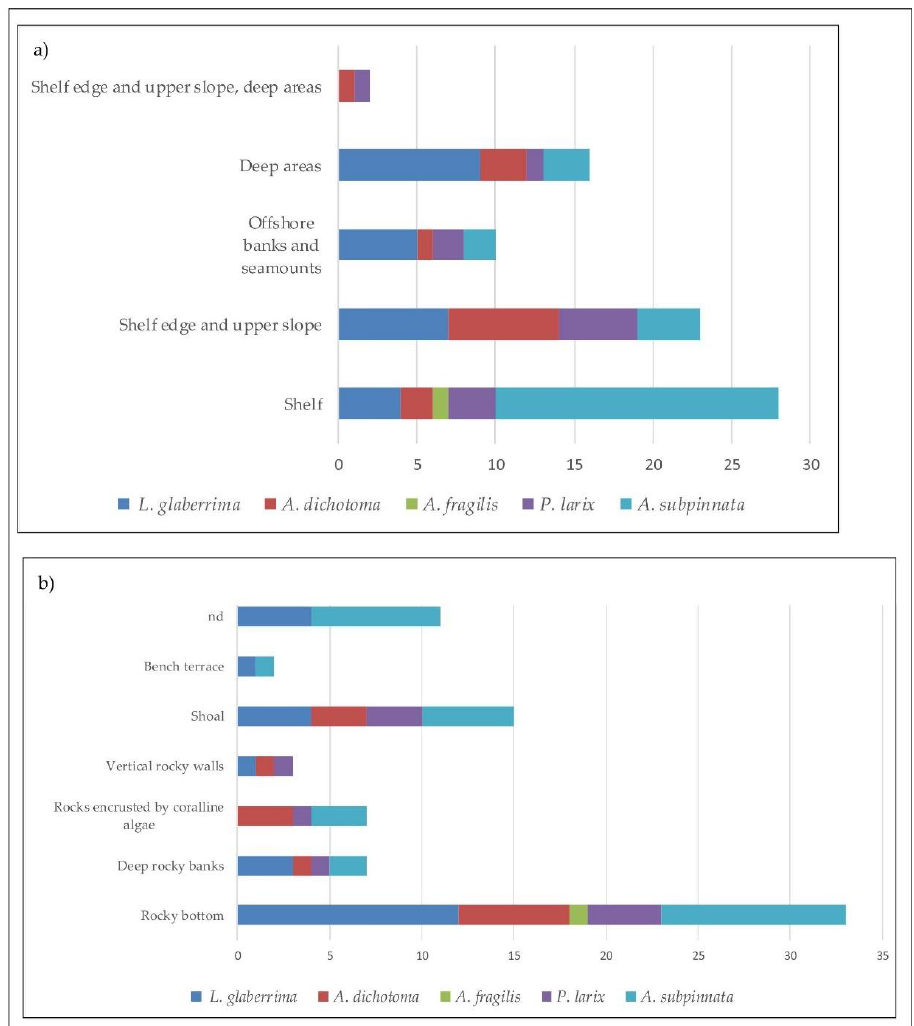
Figure 4. ( a ) Different settings and ( b ) substrate types where black corals were observed in the Italian seas.